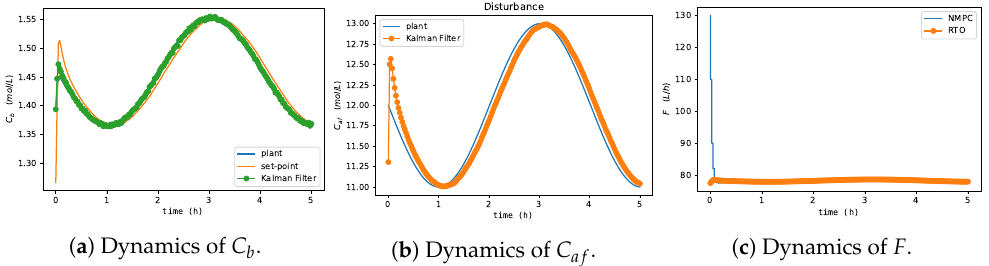
Figure 17. HRTO approach to Van de Vusse reactor economic optimization and control concerning process disturbances of Figure